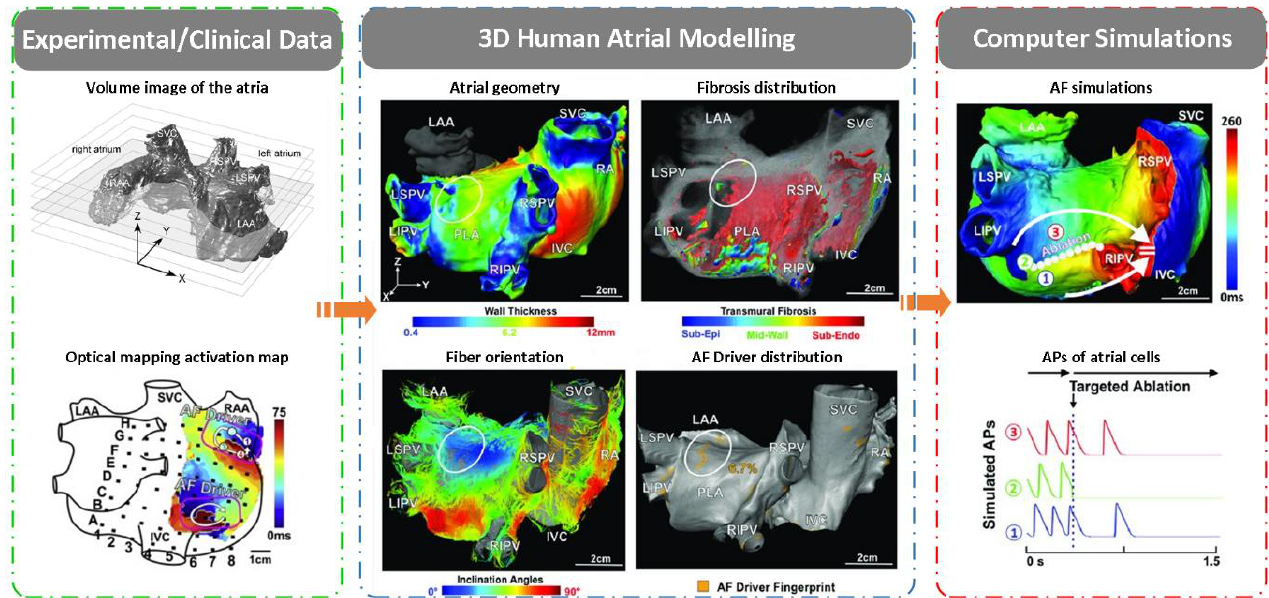
Figure 9. Schematic overview of modeling and simulation of 3D virtual human atria. Based on experimental/clinical data on MRI images and optical mapping activation map [118], atrial geometry, fibrosis distribution, fiber orientation and driver distribution were obtained and were integrated to form a virtual physiological heart considering detailed anatomy. The virtual-human atria simulation offers more quantitative and objective insight in the underlying AF substrates [117].